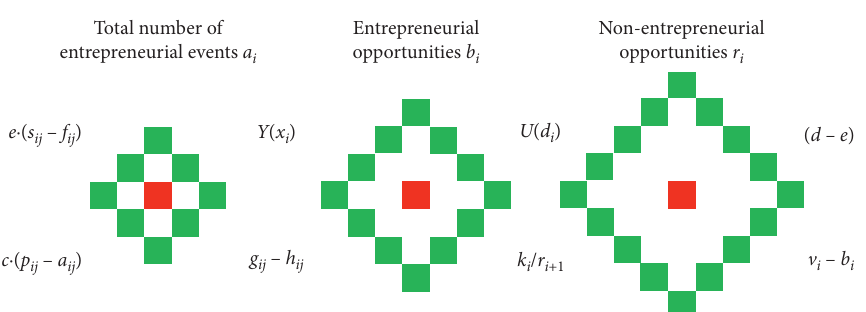
Figure 5: Case description in assessing the risk of college student entrepreneurship based on big data analysis.